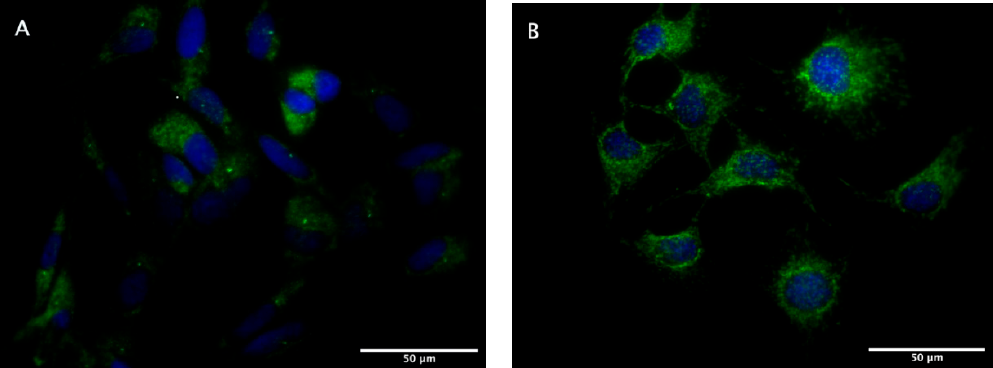
Figure 2. Representative images of LDL-R expression by indirect immunofluorescence. Blue represents cell nucleus staining, and green shows the LDL-R distribution. ( A ) Astrocytoma cells; ( B ) neuroblastoma cells. Scale, 50 µm.